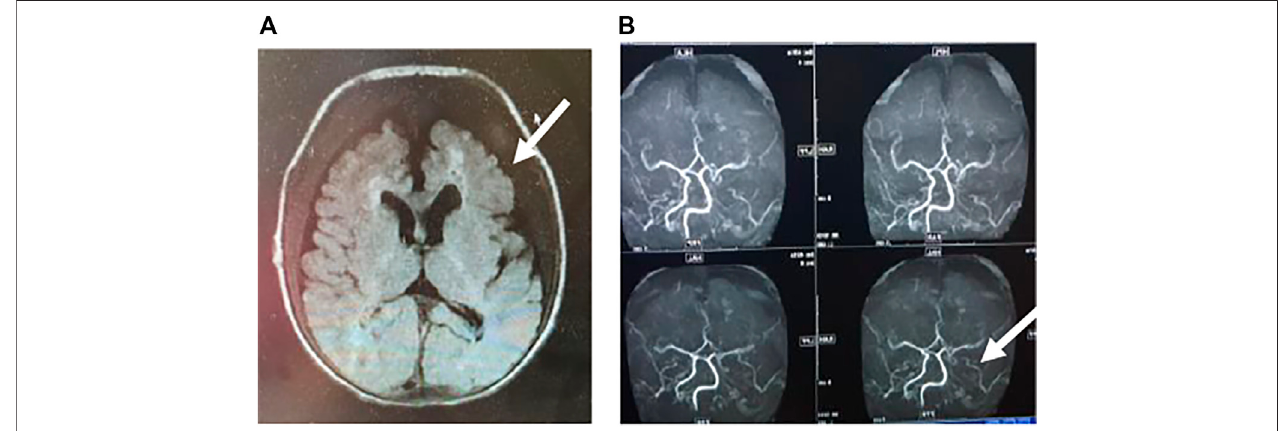
FIGURE 3 | A) Cranial MRI showing bilateral frontal and temporal lobe atrophy and abnormally high signal in the white matter around the anterior horn of the ventricle. The lesions are indicated by arrows. (B) Cerebrovascular artery MRI showing multiple luminal stenoses of the bilateral anterior, middle, and posterior cerebral arteries and vertebral arteries. The lesions are indicated by